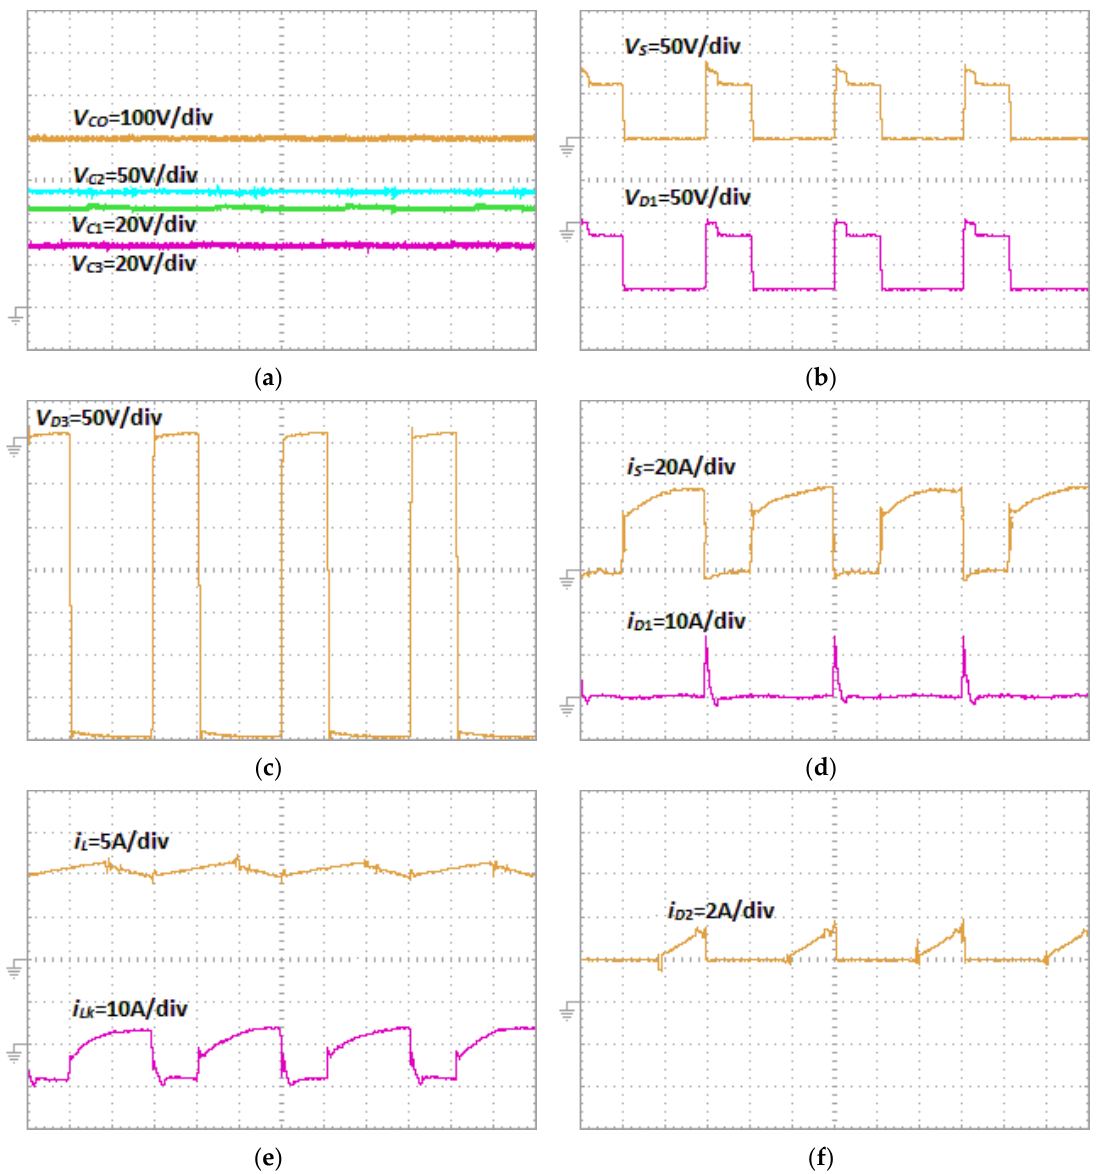
Figure 9. The experimental results: ( a ) capacitor voltages, ( b ) voltage stresses of main switch and diode D 1, ( c ) voltage stress of D 3, ( d ) current stresses of main switch and diode D 1, ( e ) inductor currents, ( f ) current of diode D 2.